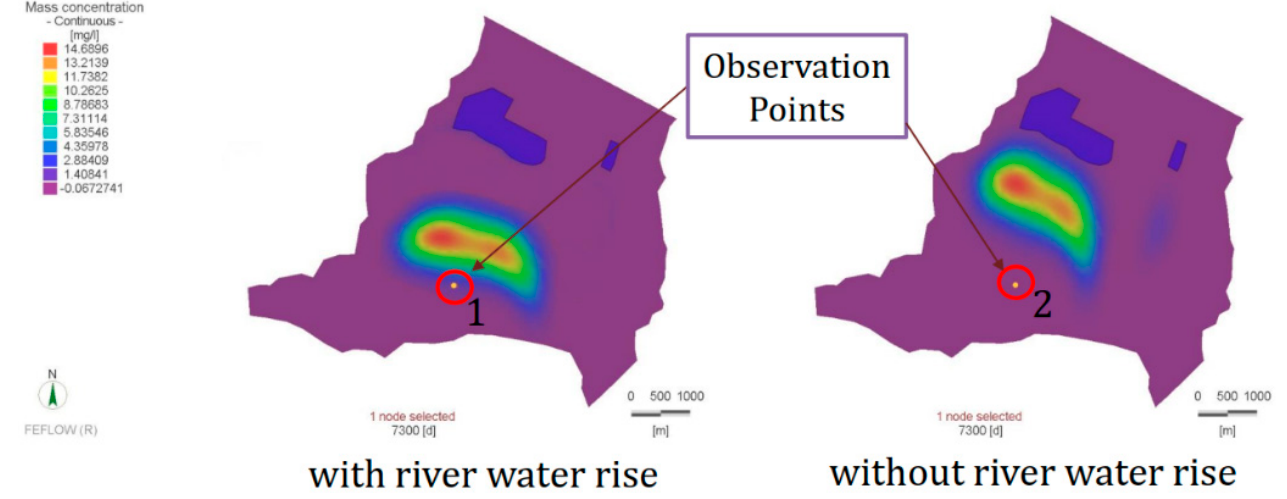
Figure 10. Spread of contaminant with and without considering the Erpe River.